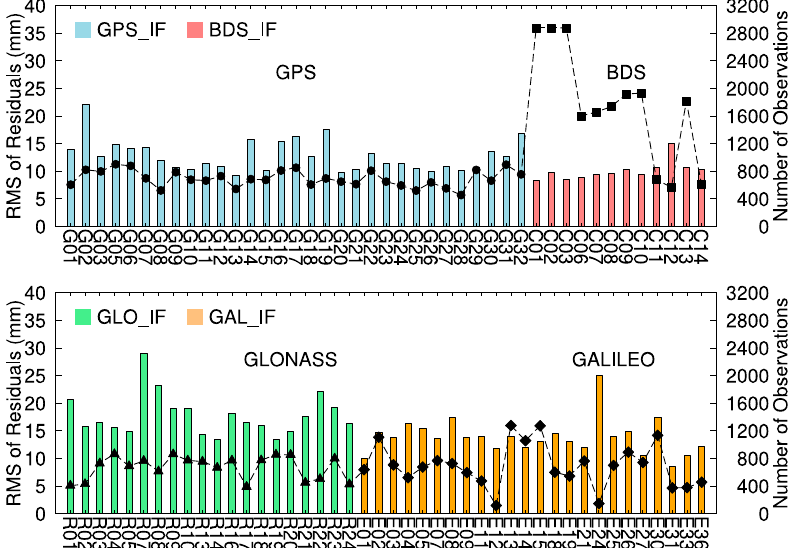
Figure 6. The posteriori residual RMS and the observation number statistics of GNSS satellites for PERT-CUT0 after solving with IF combinations on DOY